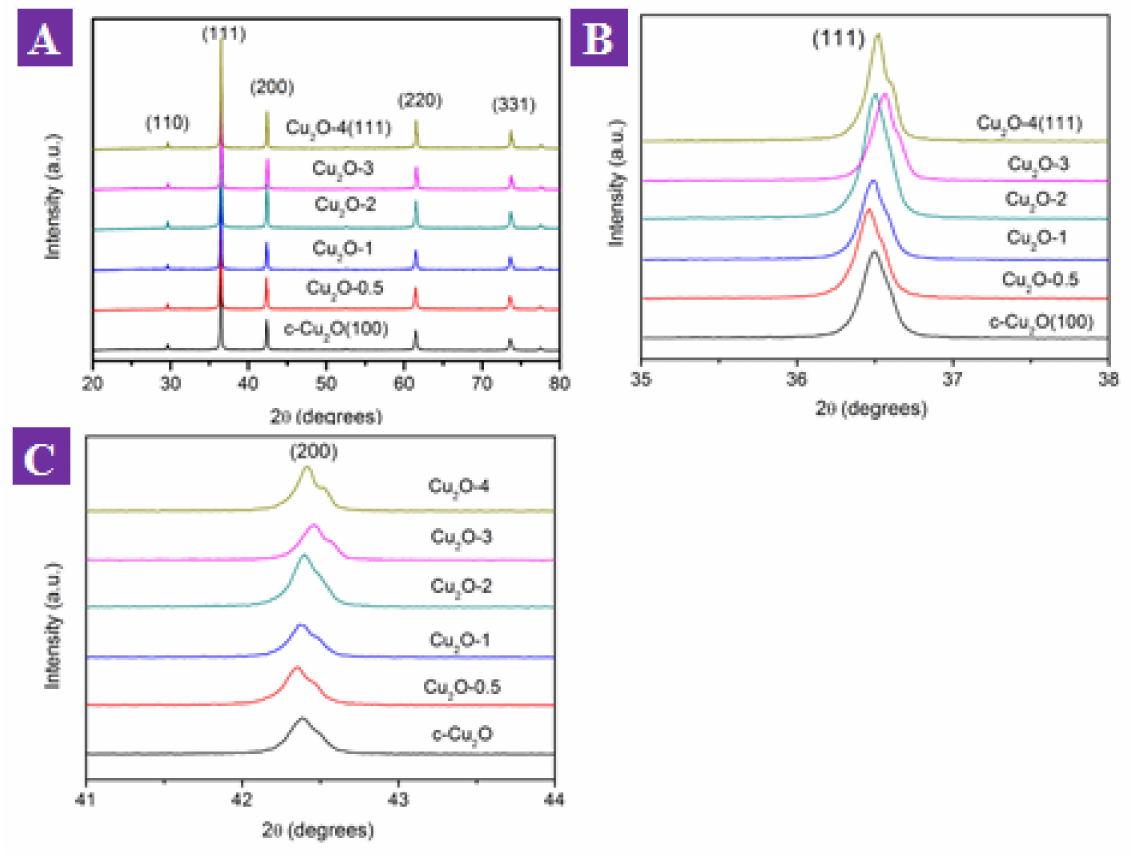
Figure 1. XRD profiles of the as-prepared samples. Enlarged view of the sample ( A ) at ( B ) (111) and ( C ) (200) crystal